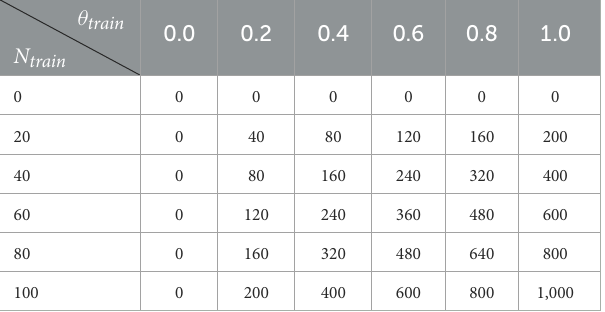
TABLE 6 Adoption rate by level of training support ( θ train ) and number of farmers concerned ( N train ): mean value for the 50 replications and standard deviation in brackets.